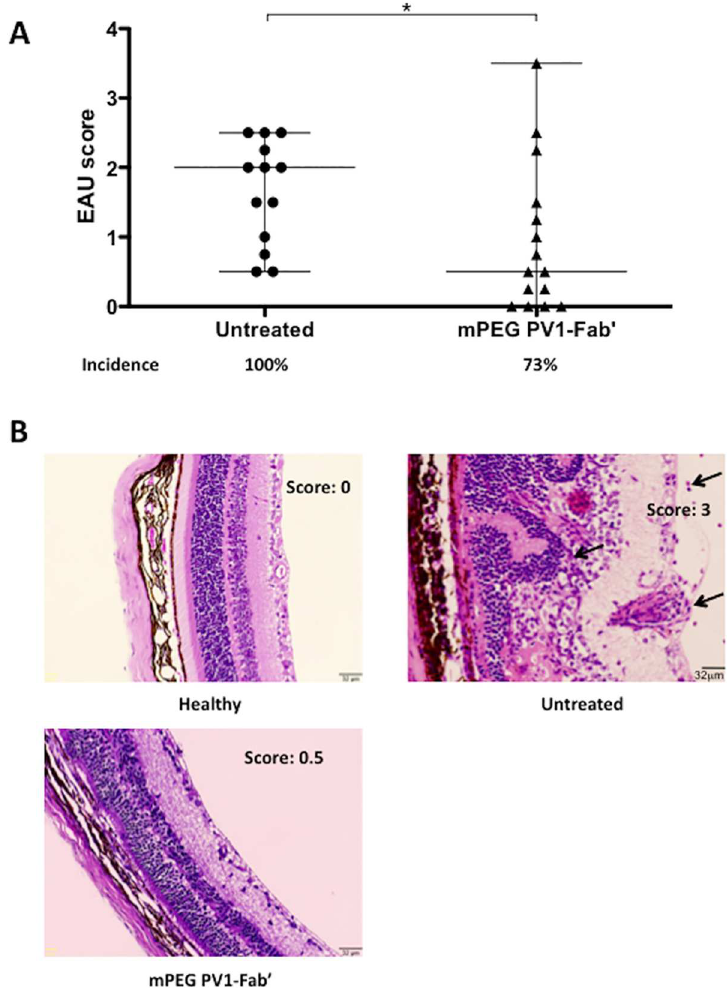
Fig 1. PV1 treatment ameliorates EAU. B10.RIII mice were immunized with 50 μ g/animalof 161–180 IRBP in CFA, plus 500 ng/animal of PTx boost. Starting on day 9, mice were treated ip every 4 days with the CD28 antagonist PV1 (10mg/Kg), or left untreated. On day 21 mice were sacrificedand eyes were collectedfor histologyanalysis. (A) EAU scores were assignedin a 0 to 4 scale, in a double-blindedfashion. (B) Representative H&E stainingof eyes (Magnification 200x) from healthymice, PV1-treated and untreated group. Histological findings such as inflammatory infiltrate, vasculitisand granulomaare indicatedby black arrows. Data combinedfrom 4 independent experiments, 5–10 mice per group. Medianand range are depictedin the scattered plot. * , p < 0.05,two-tailedMann-Whitney test.